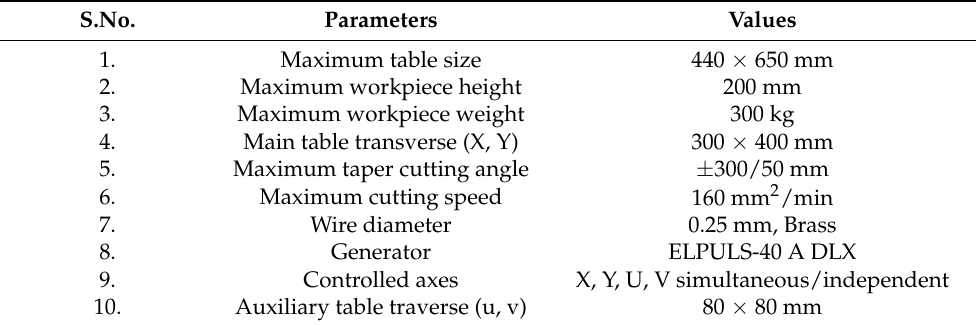
Figure 6. ( a , b ) Illustration of wire-EDM during machining. Table 2. The specifications of